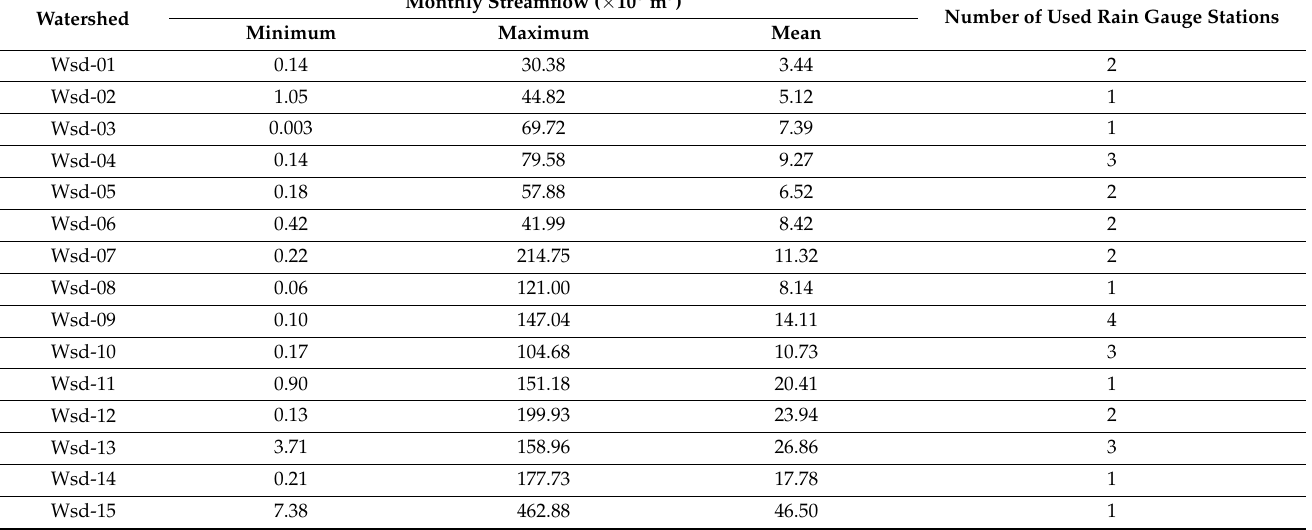
Table 3. Statistics of monthly streamflow and rain gauge station